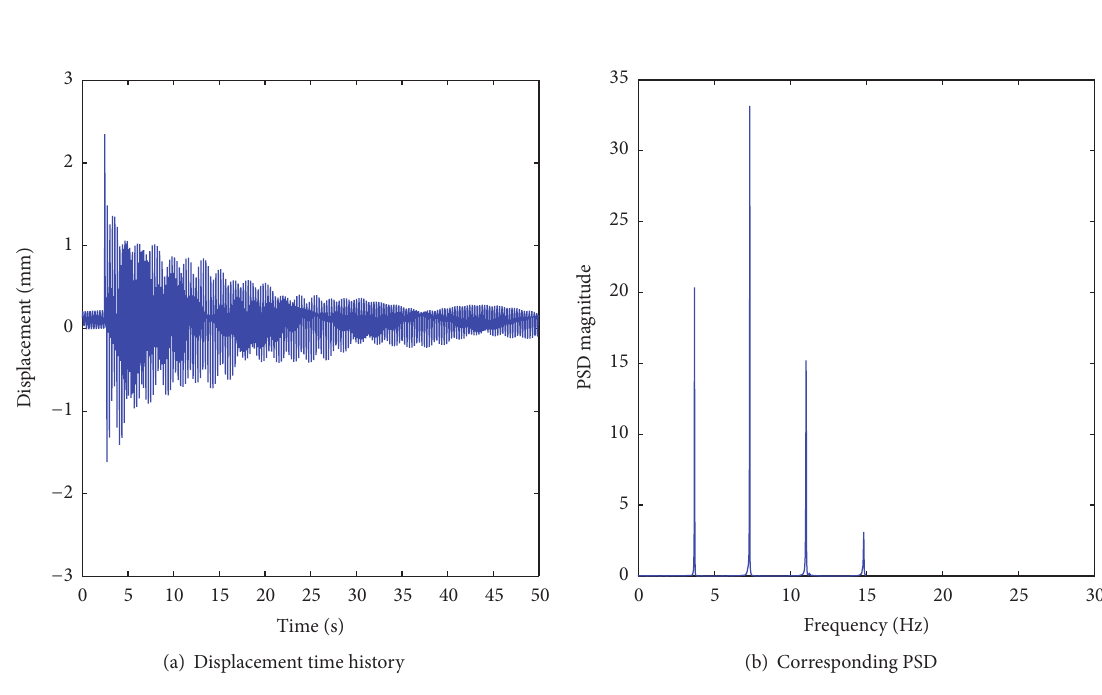
Figure 7: Results of Orion-CC.